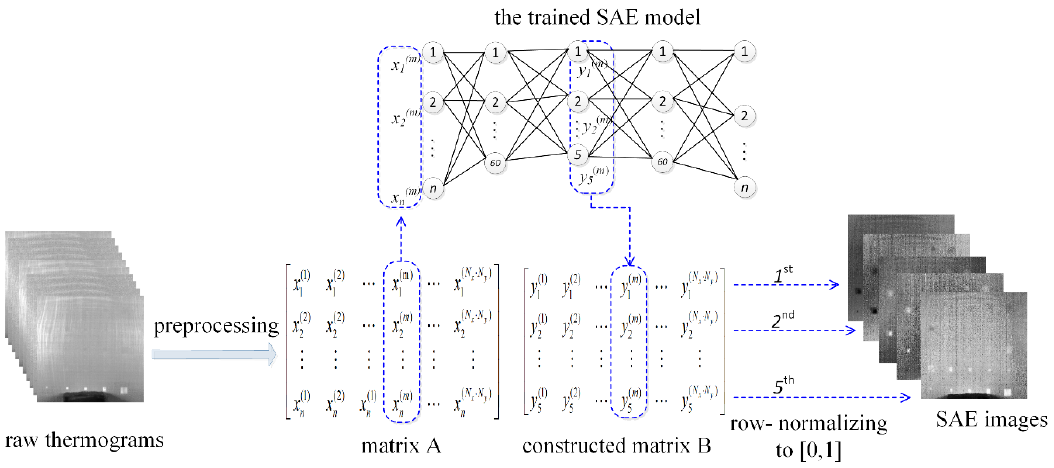
Figure 3. Construction of the SAE images.